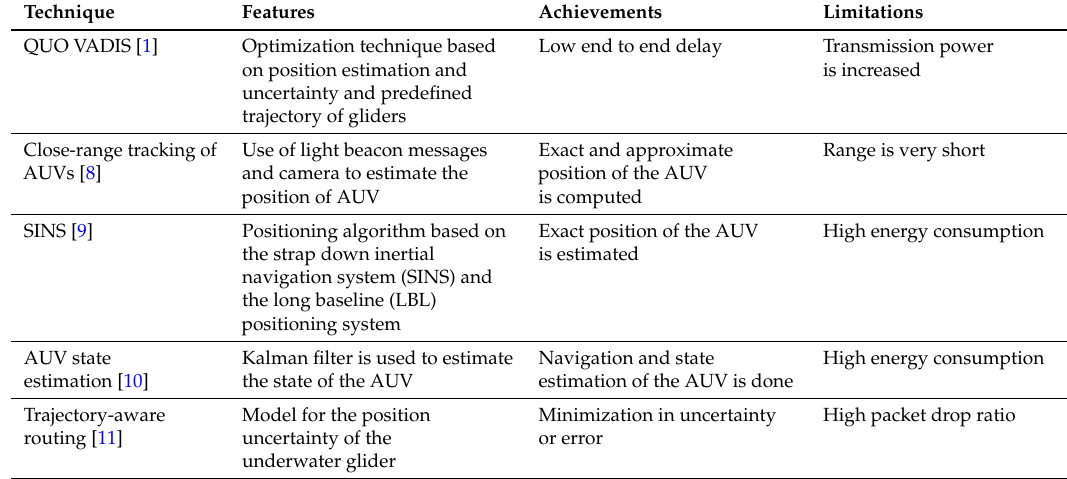
Table 1. Performance tradeoffs in existing position estimation-based routing